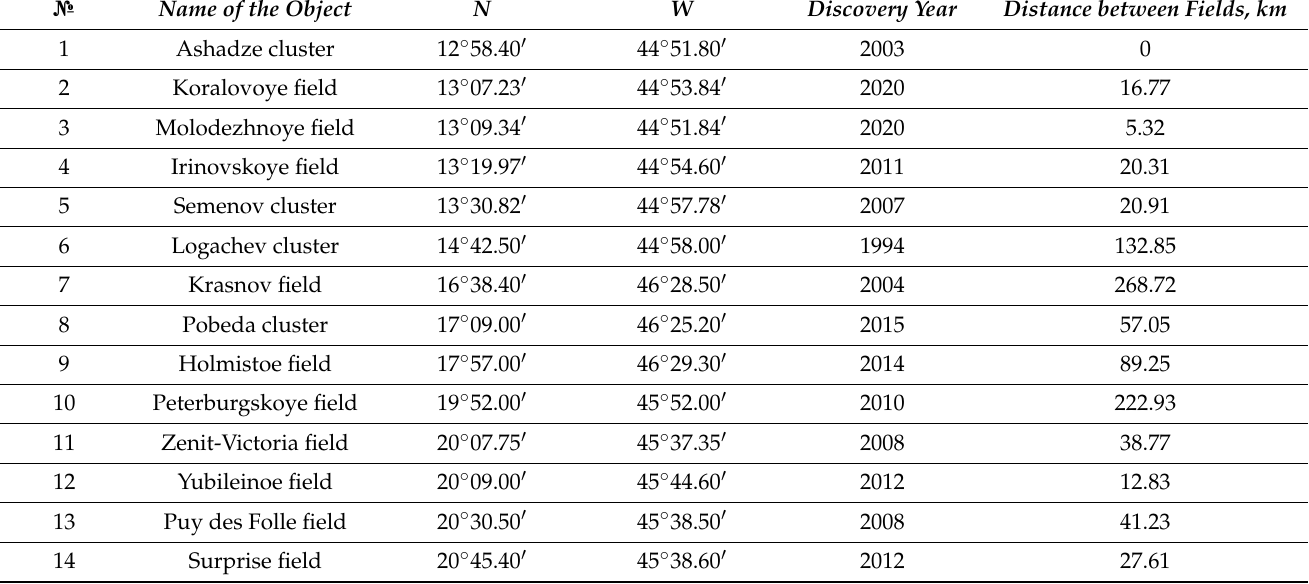
Table 1. Hydrothermal fields and clusters within the REA and the distances between them (from south to